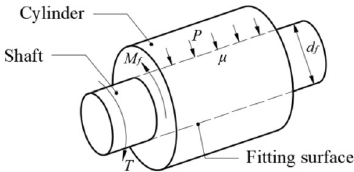
(a) Disassembly damage simulation experiment